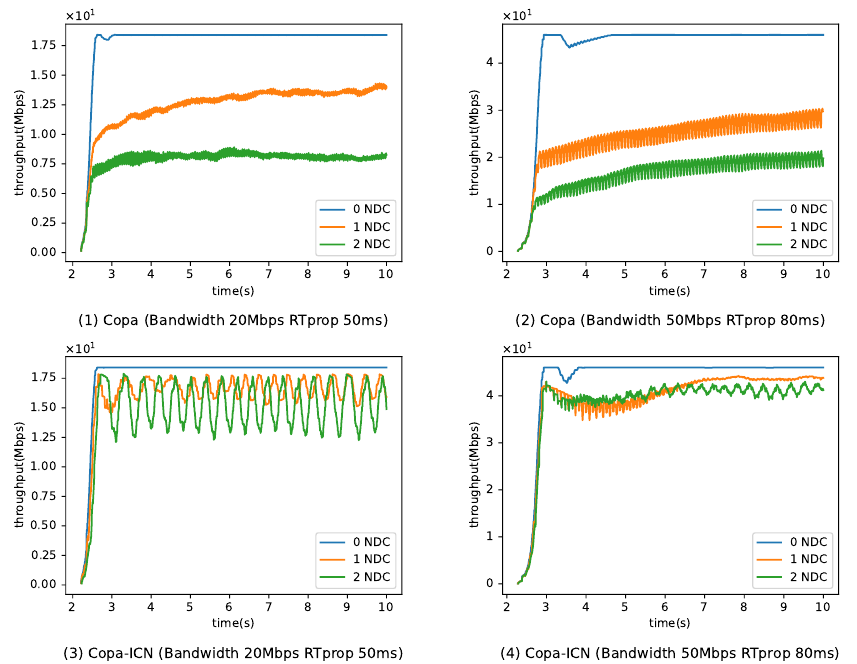
Figure 12. Variation of throughput over time for different factors (algorithm, bottleneck bandwidth, RTprop, and number of NDC transmission processes in opposite